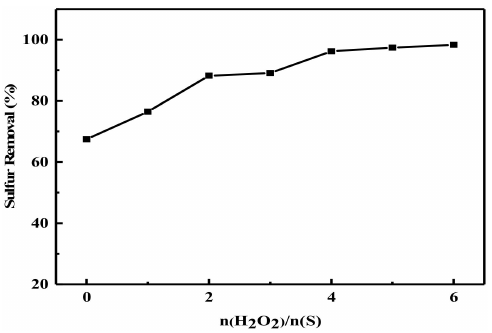
Figure 7. Effect of the mole ratio of oxidant to sulfide on desulfurization. Reaction conditions: V(oil) = 5 mL; n(catalyst)/n(S) = 0.025; V(acetonitrile) = 0.5 mL; t = 60 min; T = 50 ◦ C.